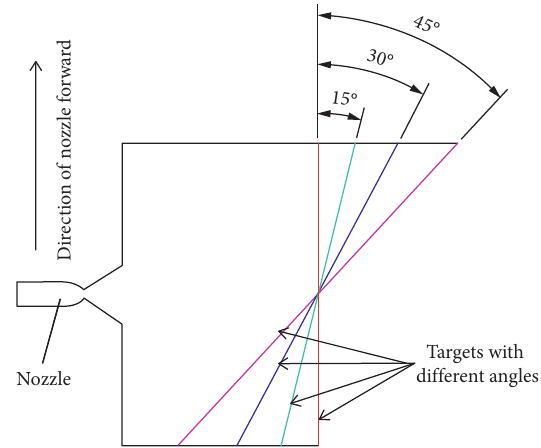
Figure 10: Model schematic diagram different from normal angle of target surface.